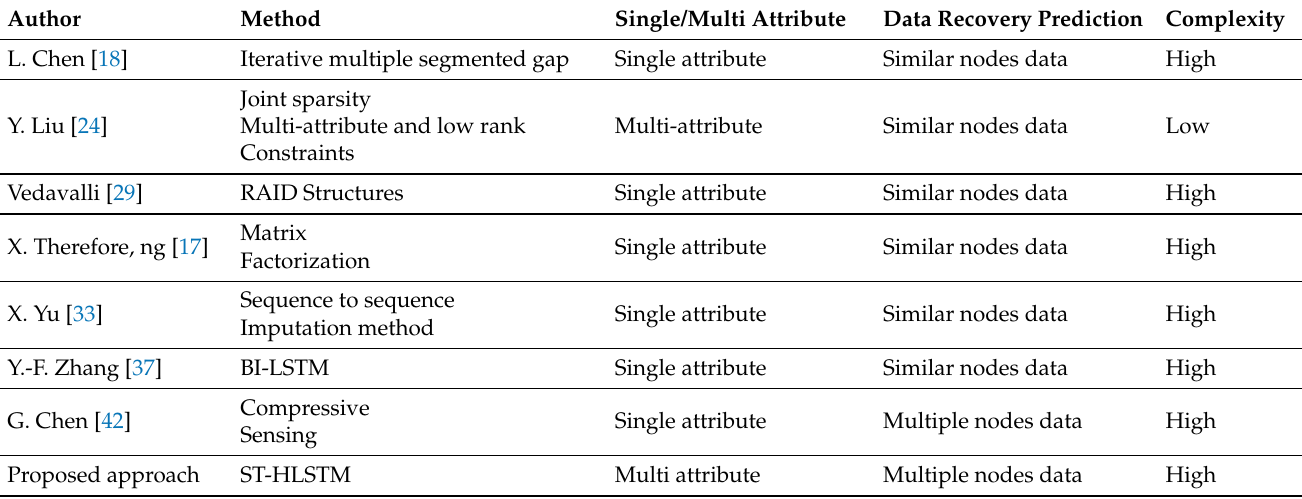
Table 2. Comparison of various data recovery approaches with the proposed